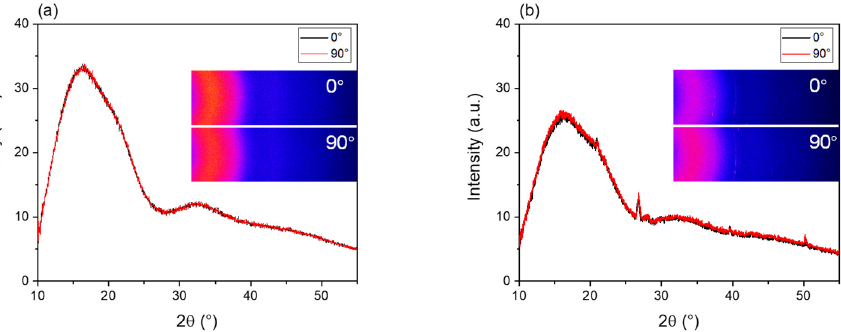
Figure 12. Wide-angle X-ray diffraction (WAXD) profiles and two-dimensional patterns at azimuthal angles of 0 and 90° for ( a ) PLLA and ( b ) BC/PLLA films.